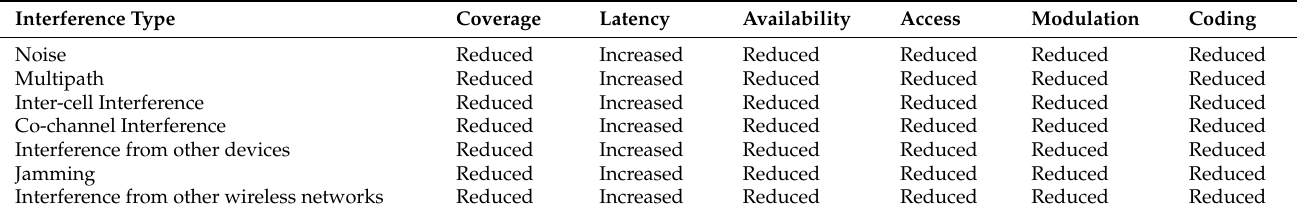
Table 4. Types of interference that impact 5G networks and